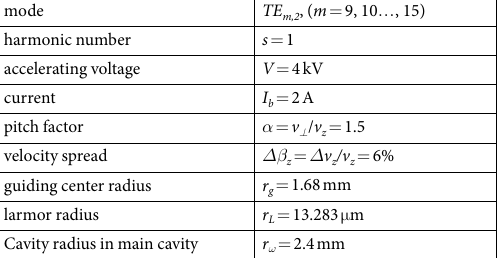
Table 1. Operating parameters of the THz frequency-tunable gyrotron.